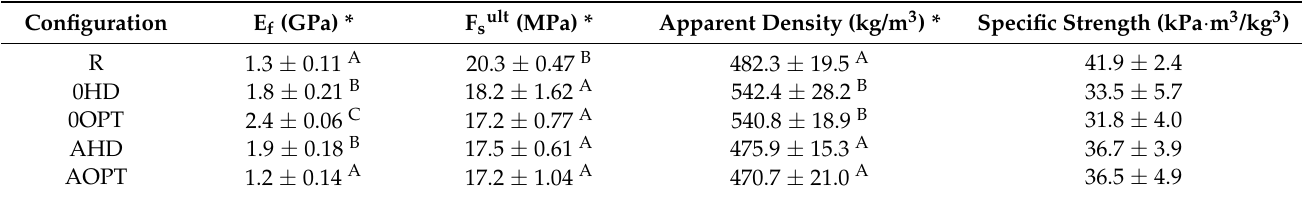
Table 4. Compilation of the sandwich structures’ properties from experimental tests.